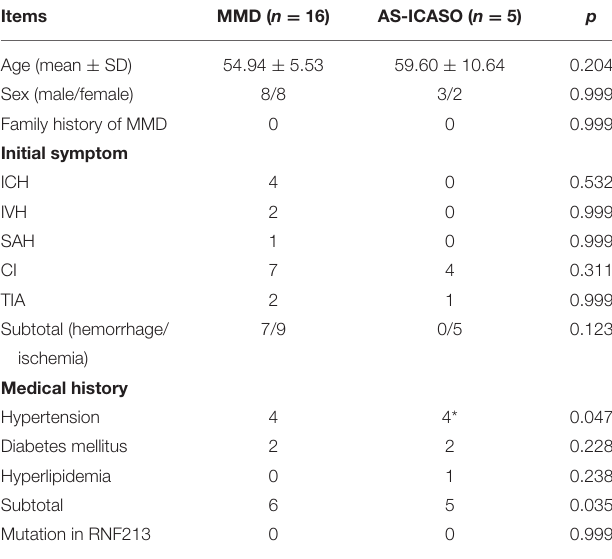
TABLE 1 | Summary of the demographic and clinical characteristics of all